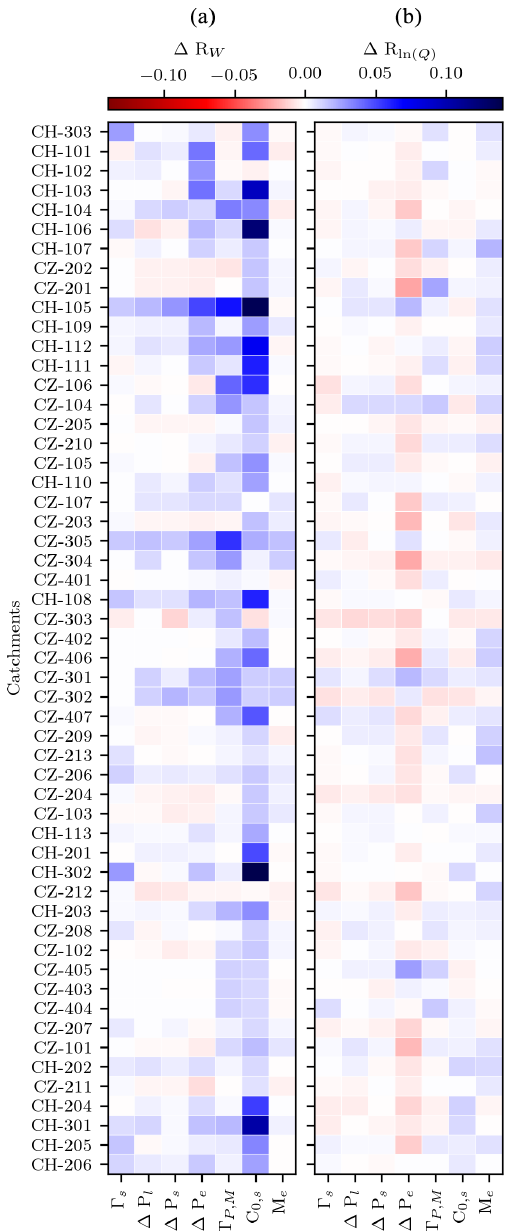
Figure 5. Median relative model calibration performance for al- ternative HBV model structures, including modifications to single components of the snow routine with respect to HBV. The modi- fications include a seasonally variable temperature lapse rate ( (cid:48) s ), a linear, sinusoidal, and exponential function for the precipitation phase partition ( (cid:49)P l , (cid:49)P s , and (cid:49)P e respectively), different thresh- olds for precipitation phase and snowmelt ( T P , M ), a seasonally vari- able degree-day factor ( C 0 , s ), and an exponential snowmelt with no refreezing ( M e ). (a) Model calibration against snow water equiva- lent; (b) model calibration against logarithmic stream runoff. The catchments are ordered by mean yearly snowmelt contribution to runoff in downwards increasing order.